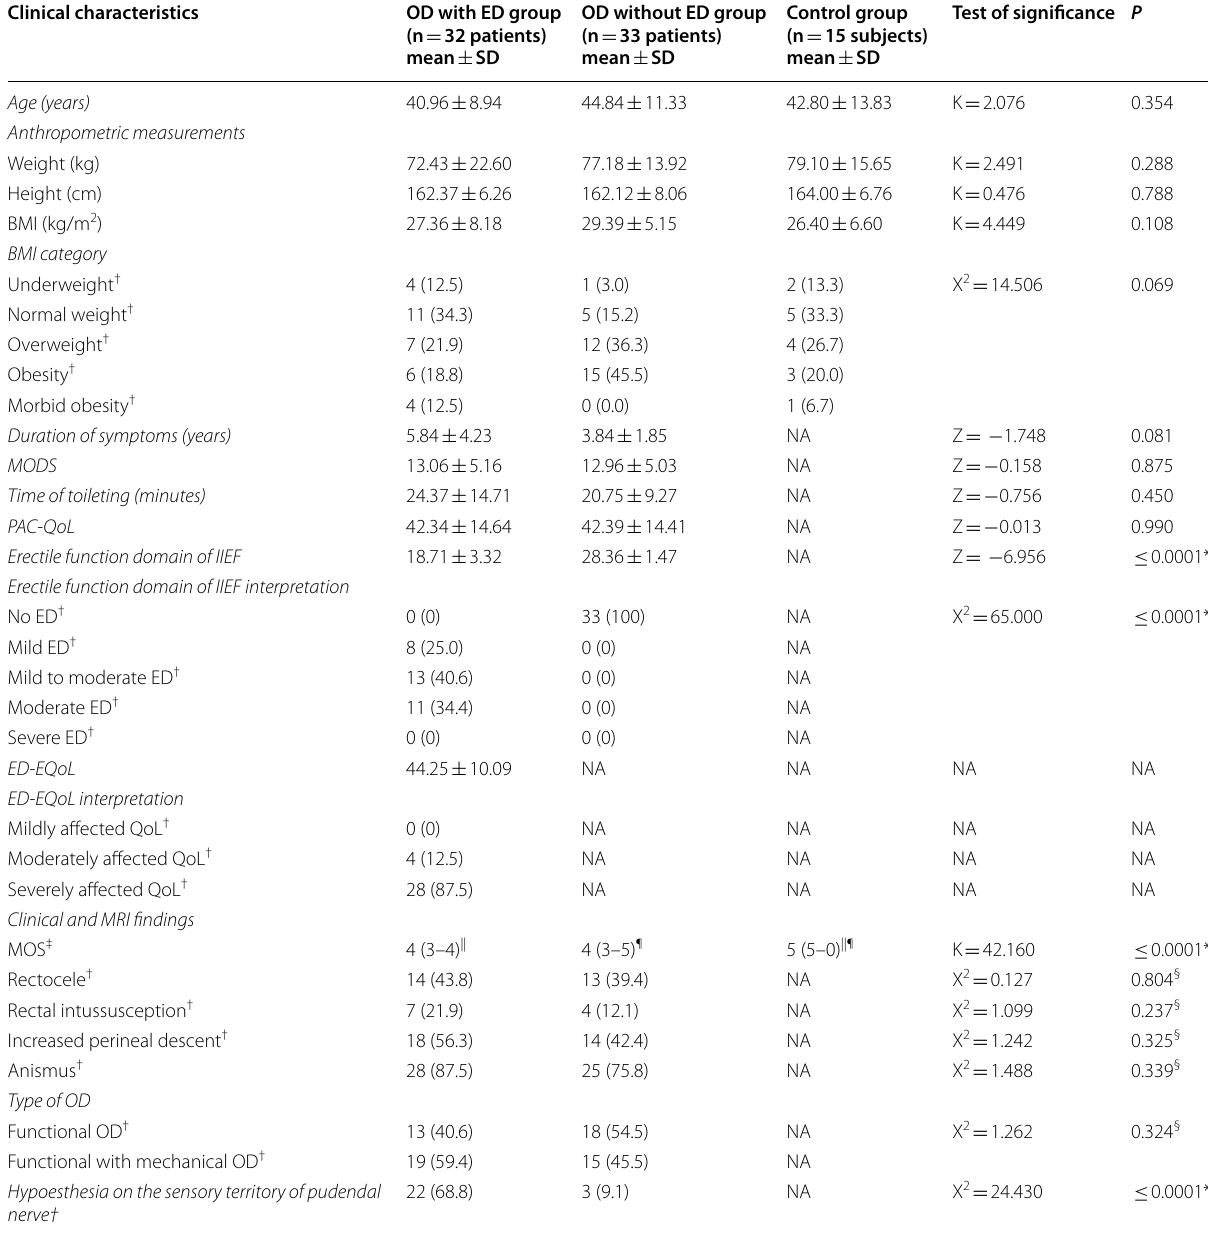
Table 1 Clinical characteristics of the two patient groups and control